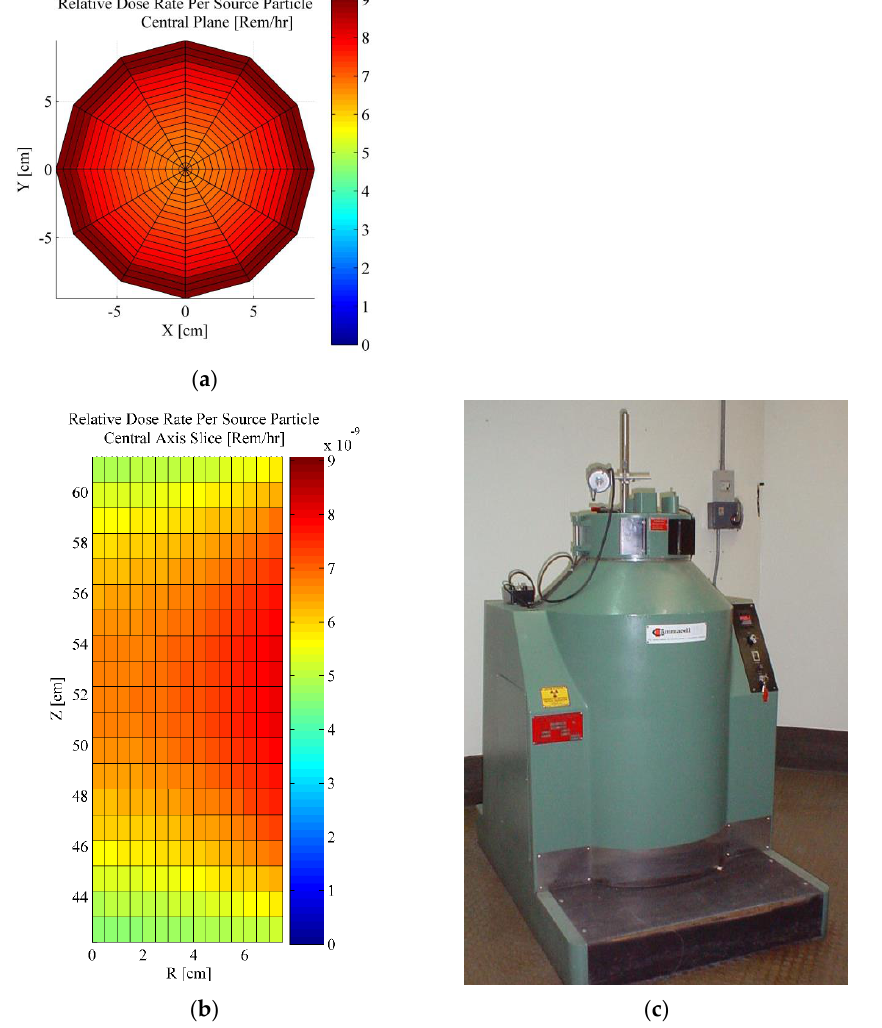
Figure 3. MCNP code model results [11] of dose rate variations in Purdue University’s Gammacell Irradiator: ( a ) Mid section, axial; ( b ) R-Z slice, radial; ( c ) Irradiator [22].